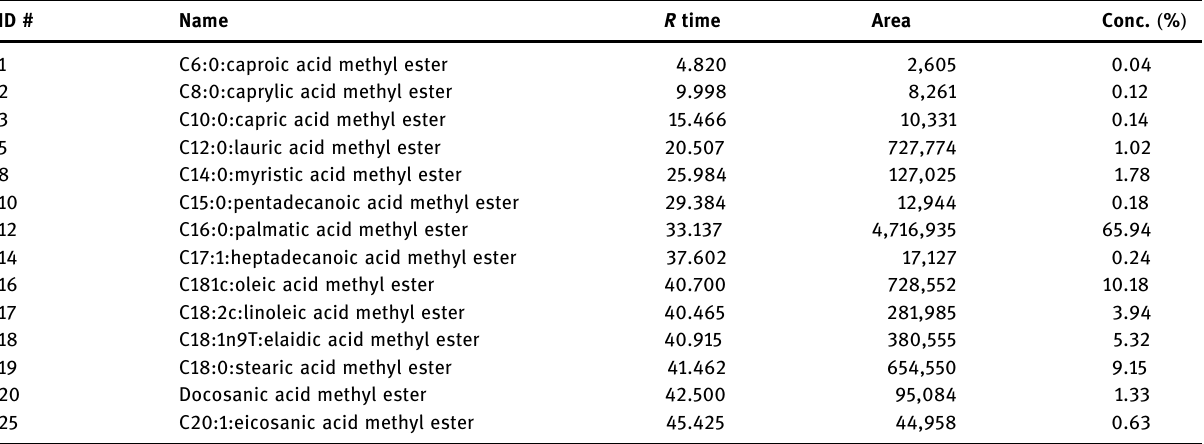
Table 3: Quantitative results of oil extracted from CO fraction of F. benghalensis ID #